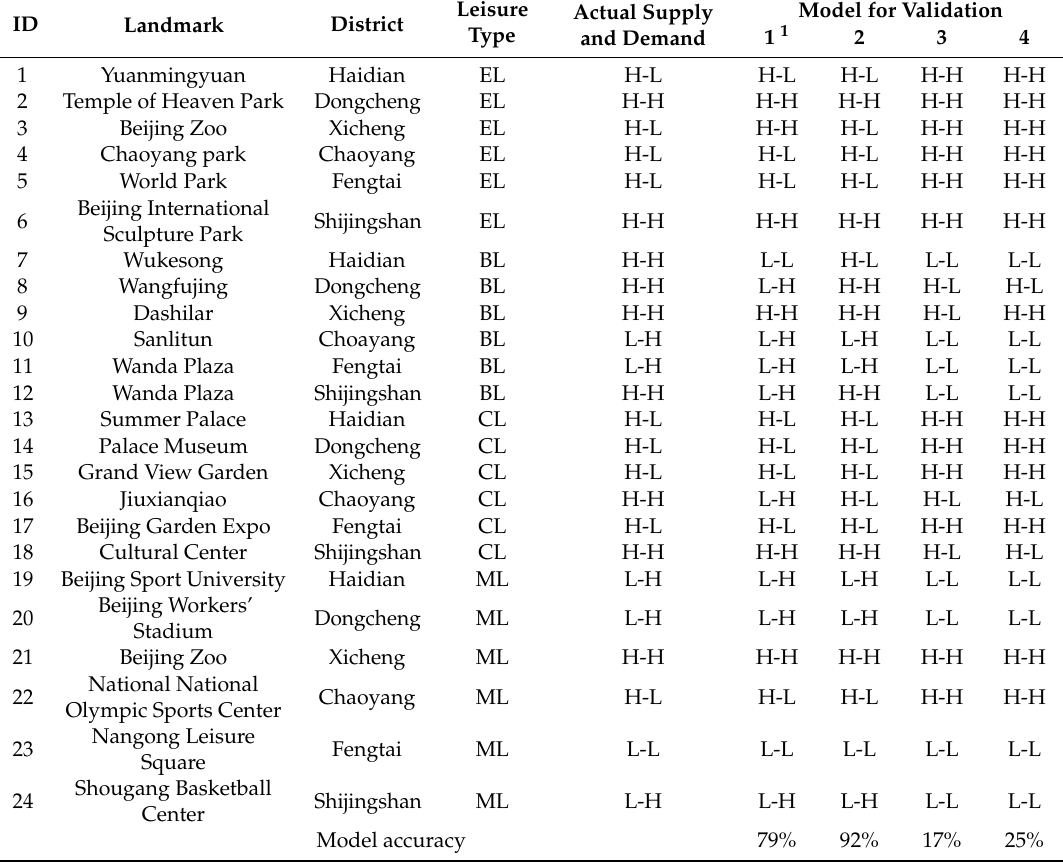
Table 3. Comparison of the actual supply and demand and calculated